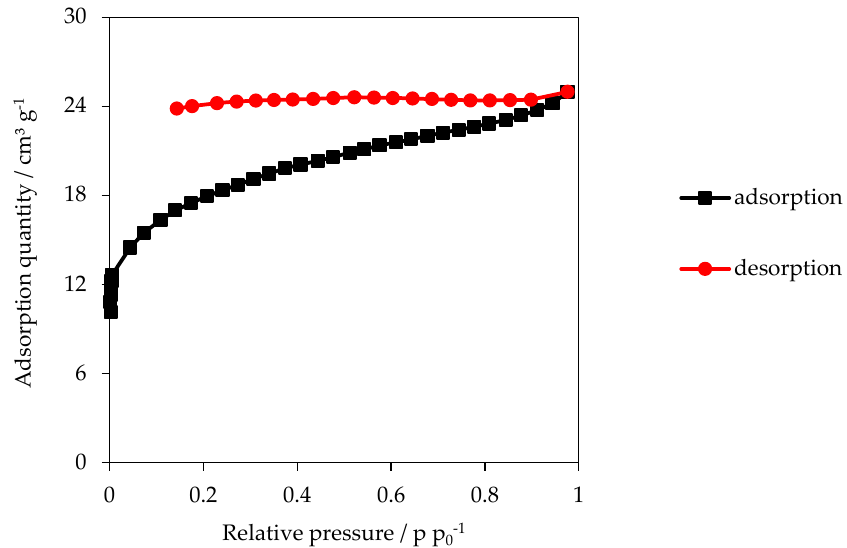
Figure 5. Adsorption isotherm P600 ‐ 200 ‐ 5. Adsorptive: nitrogen.